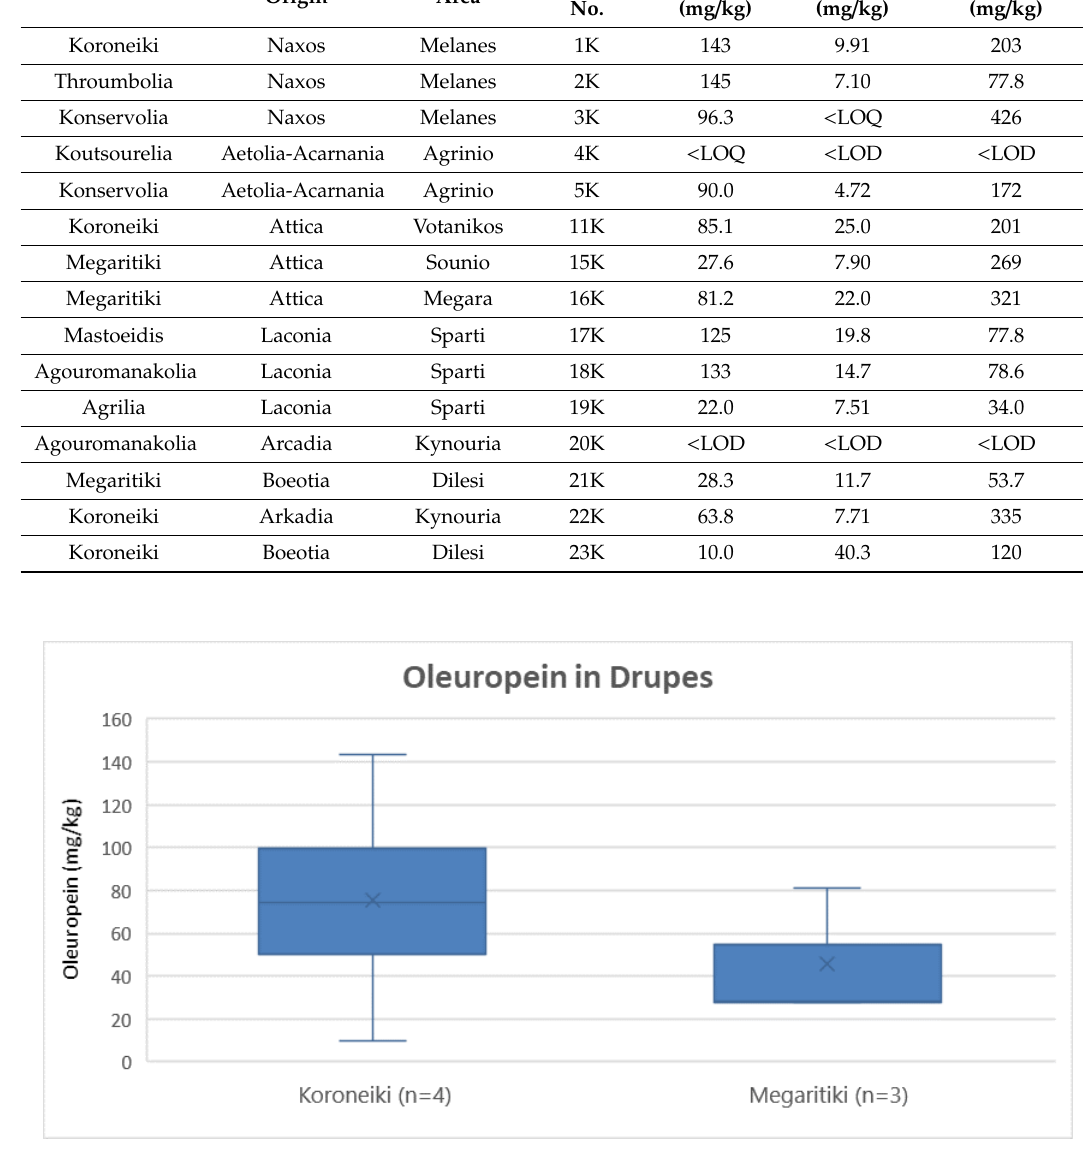
Figure 10. Box and whisker plot for the concentrations of oleuropein between different varieties of drupes.